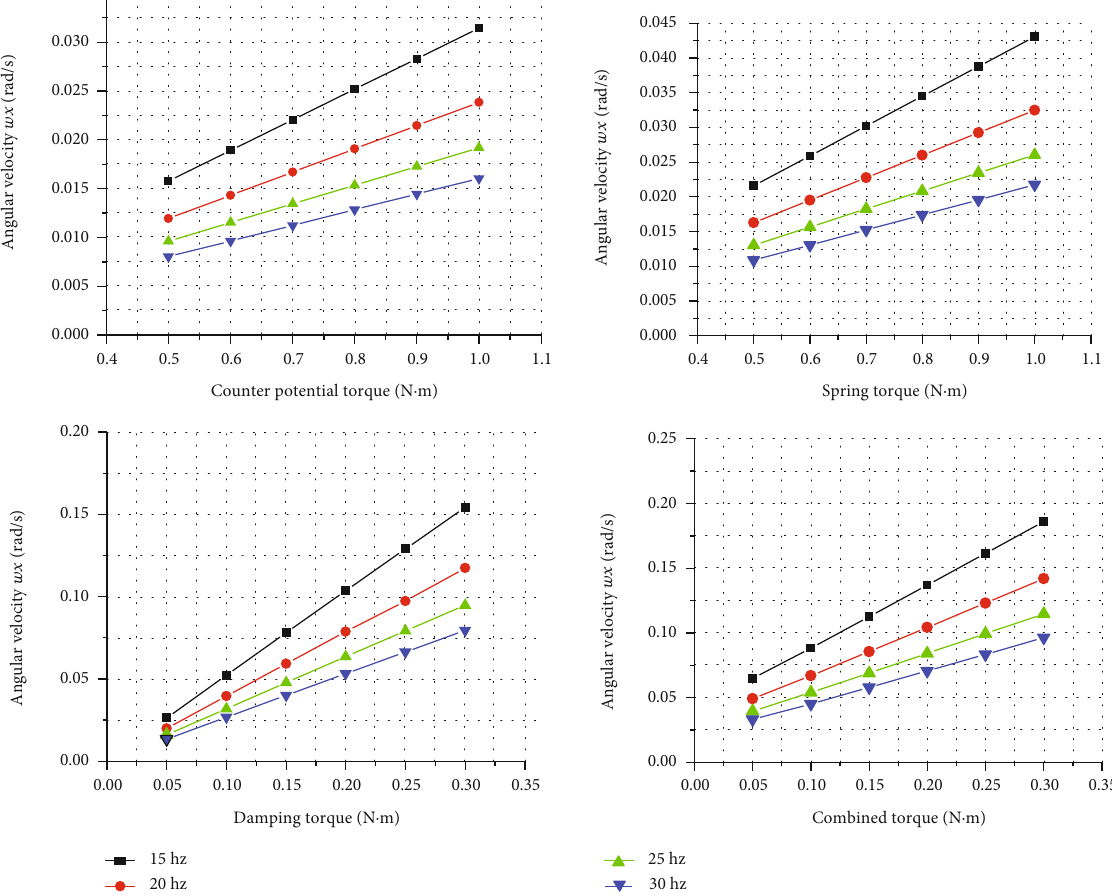
Figure 15: Angular velocity of the frame with di ff erent frequency bands after ESO compensation.